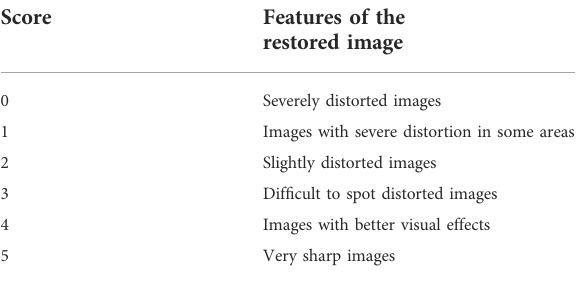
TABLE 5 Subjective quality evaluation of a scoring method. Score